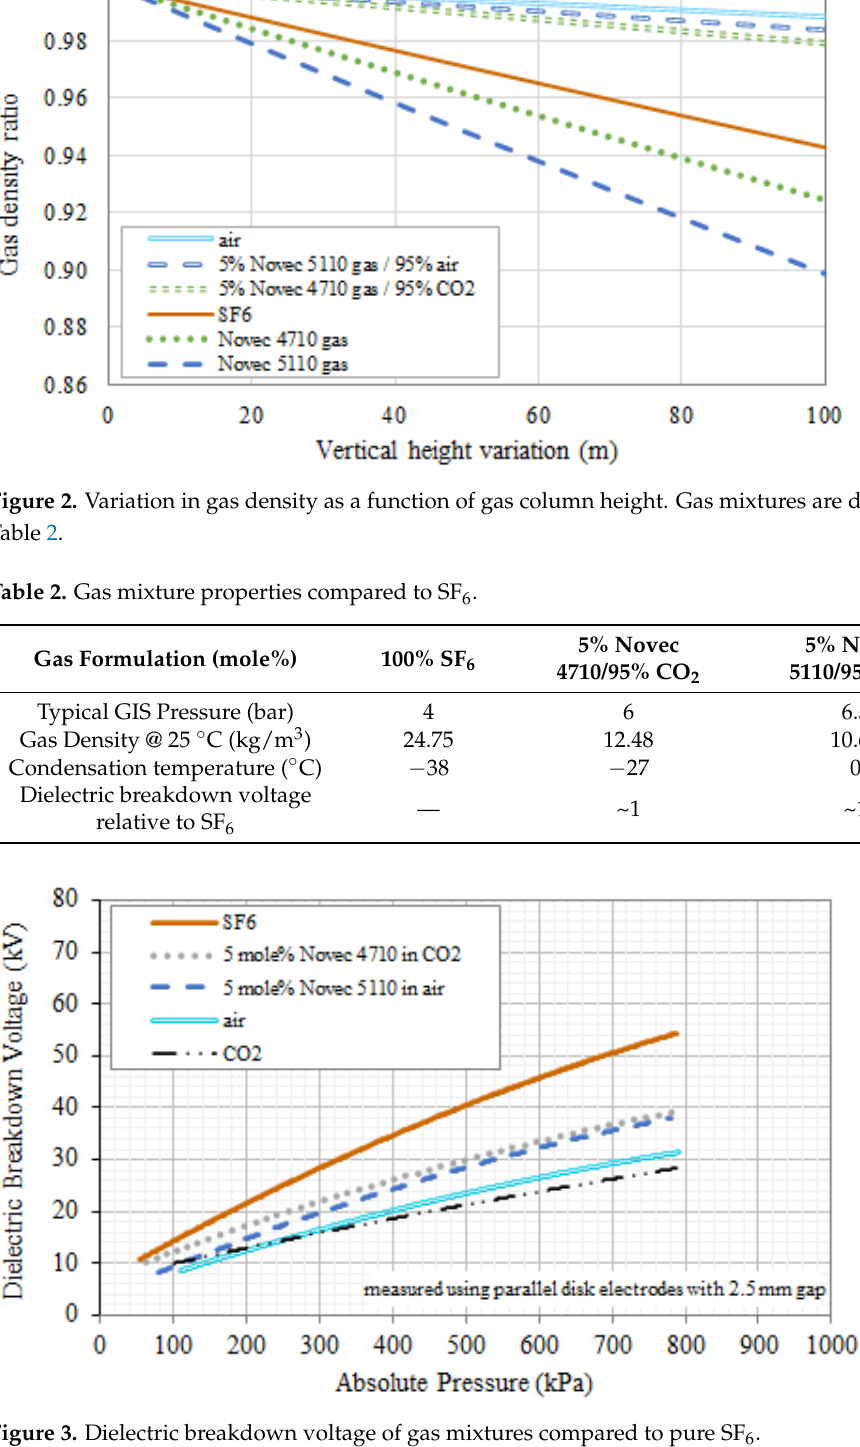
Figure 3. Dielectric breakdown voltage of gas mixtures compared to pure SF 6